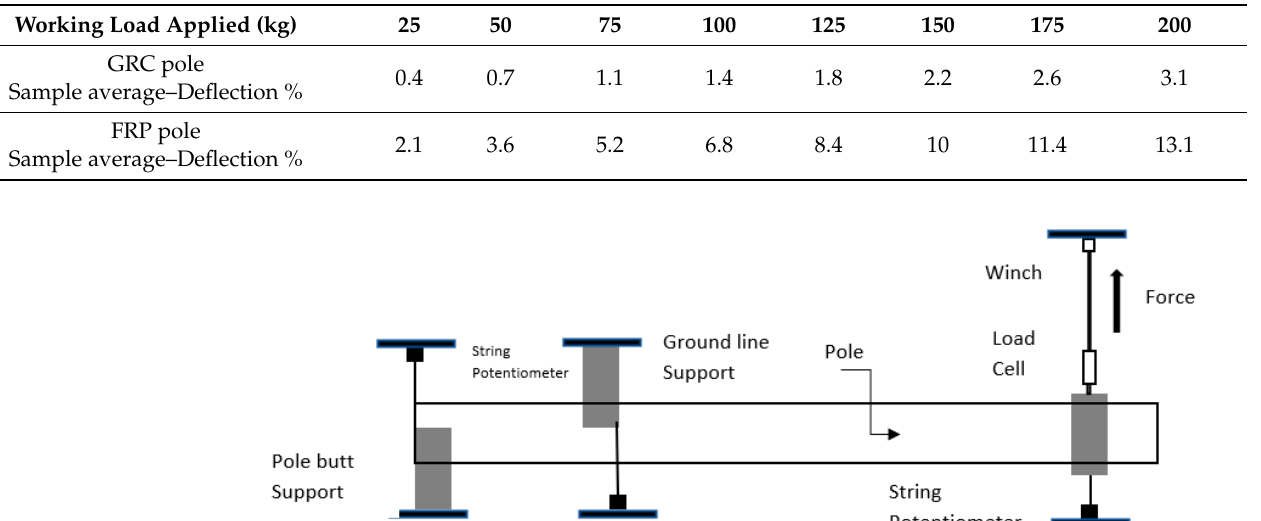
Table 4. Deflection comparison—GRC vs FRP poles.